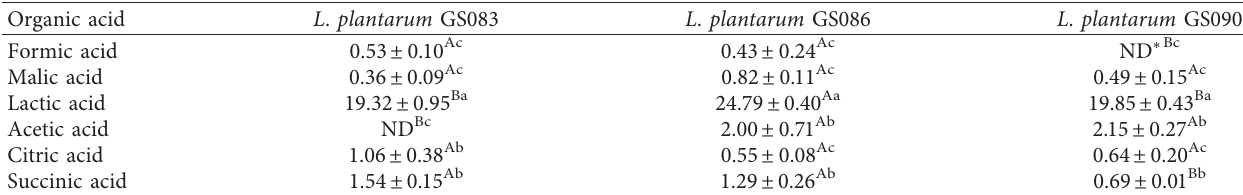
Table 2: Quantitative detection of organic acids by HPLC